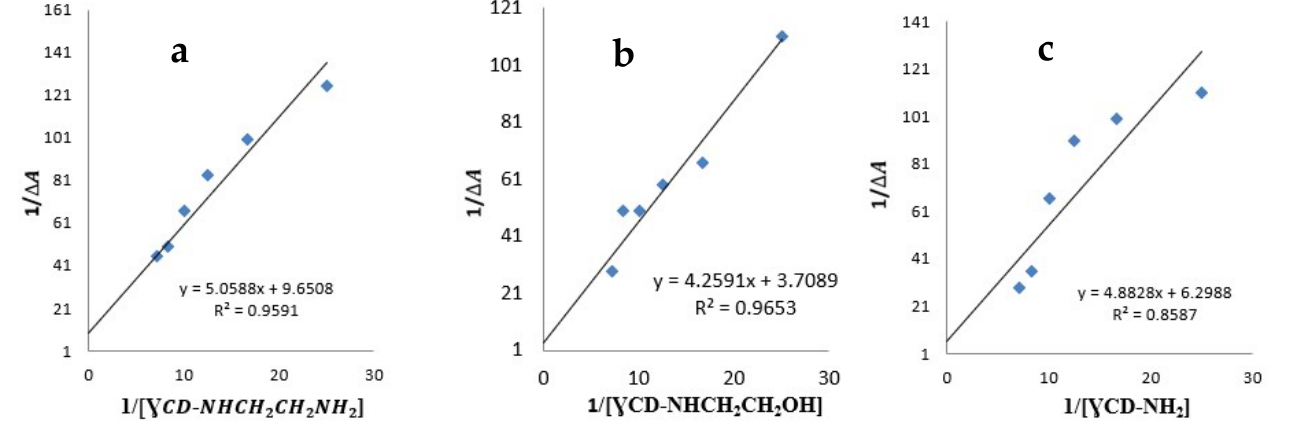
Figure 6. Benesi–Hildebrand plot of 1/ ∆ A versus 1/[modified of γ -CDs] for CUR modified of γ Figure 6. Benesi – Hildebrand plot of 1/∆ A versus 1/[modified of γ-CDs] for CUR modified of γ-CDs inclusion complexes ( a ) γ-CD-NH 2, ( b ) γ-CD-NHCH 2 CH 2 NH 2 , and ( c ) γ-CD-NHCH 2 CH 2 OH.